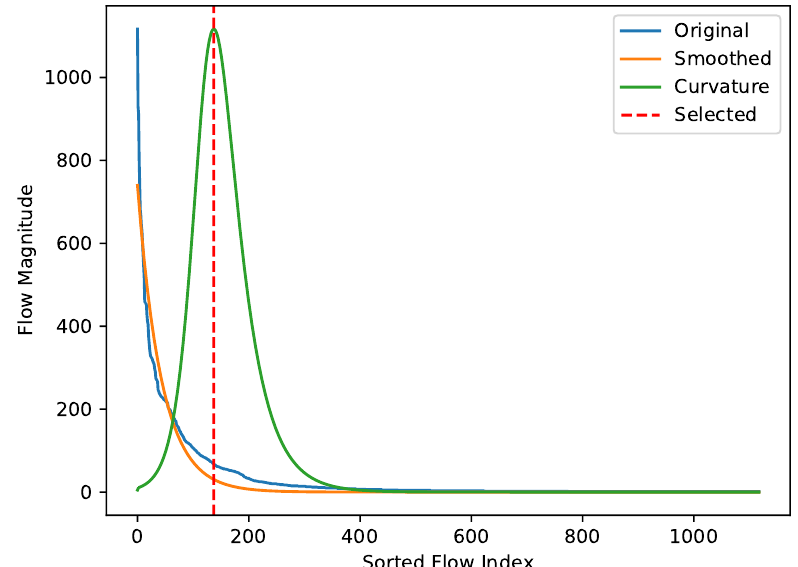
Figure 5. Selection of classification threshold using the derivative of the curvature